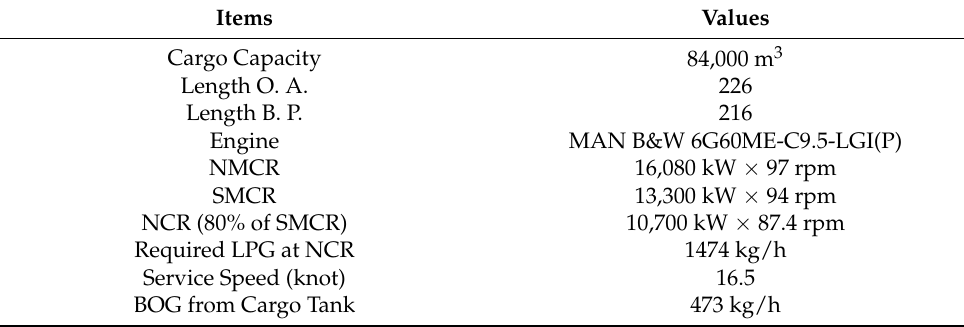
Table 1. Basic information of target vessel.